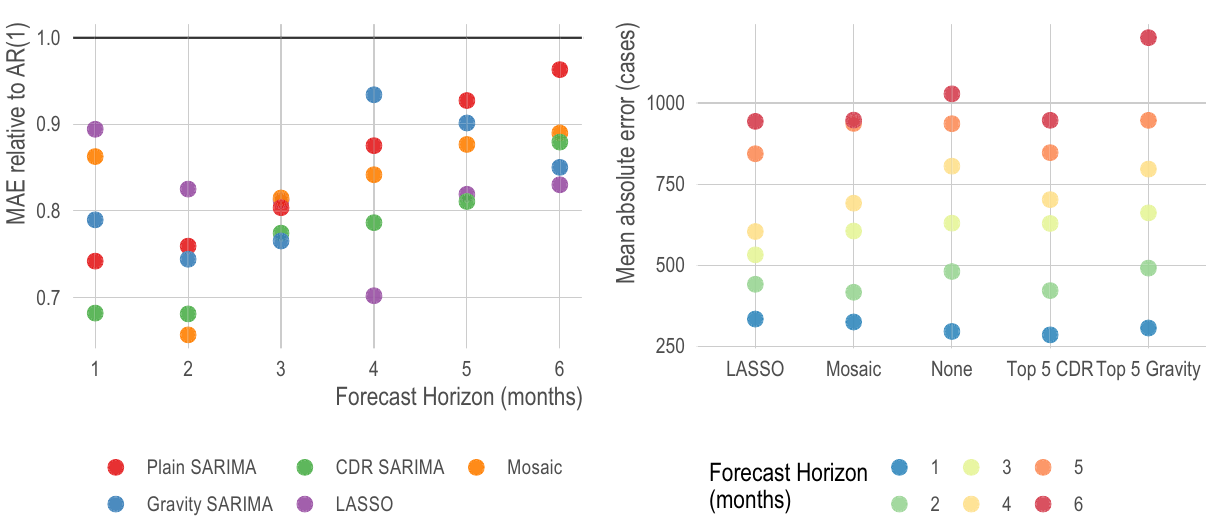
Figure 2. Comparing the best models for Bangkok, by model type. Focusing only on the best performing model for each model type and each time horizon, we show the relative mean absolute error (left panel) and the mean absolute error (right panel). On the left, the baseline of comparison is the traditional AR(1) model and the y-axis can be interpreted as the improvement over this baseline—i.e., a value of .9 indicates a 10% improvement. We show that both the Plain SARIMA (red) and CDR SARIMA (green) models perform better than the LASSO model at earlier forecasting horizons but perform worse at later